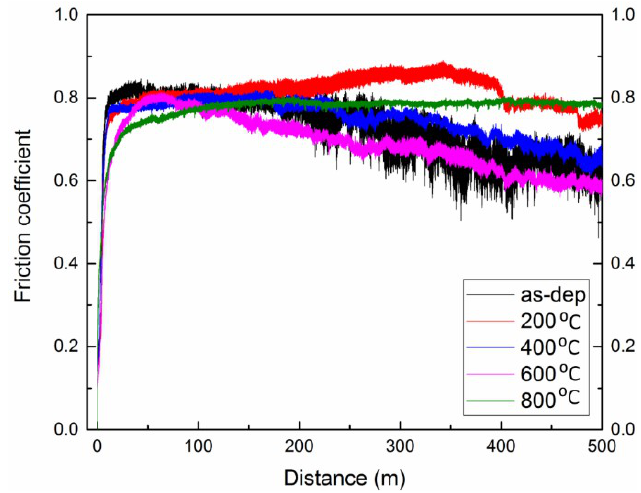
Figure 5. Coefficient of friction (COF) evolution for the as-deposited and annealed Fe-24W coatings.